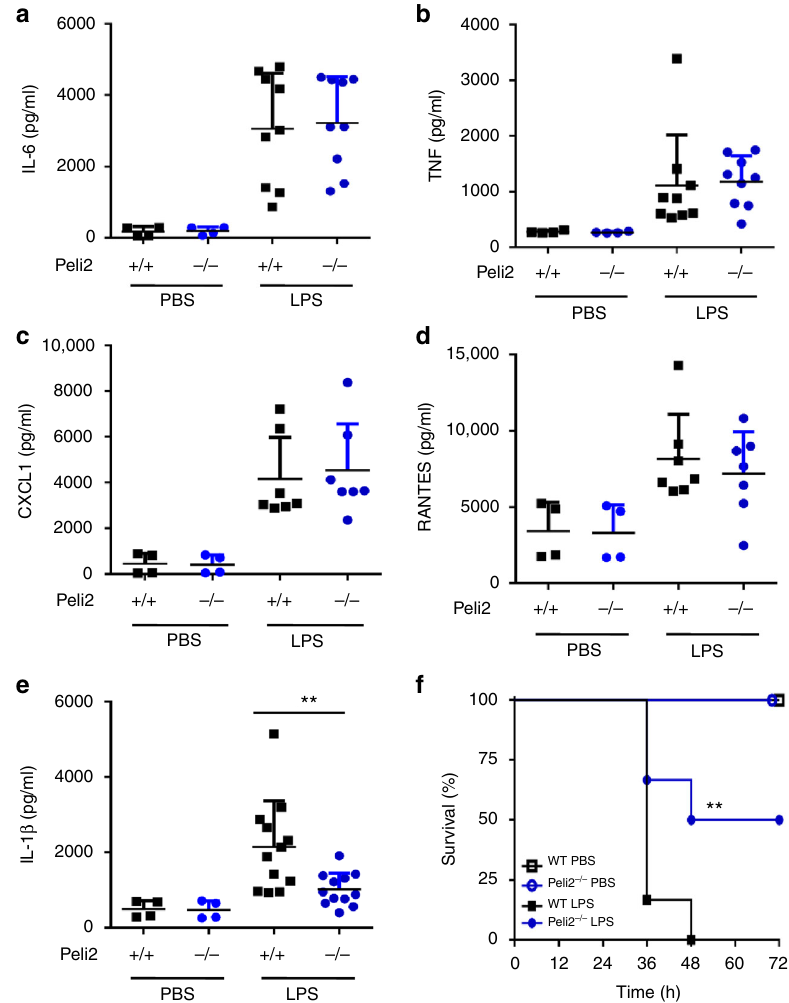
Fig. 3 Pellino2 is required for in vivo expression of IL-1 β and lethality in response to LPS. ELISA of a IL-6, b TNF, c CXCL1, d RANTES, and e IL-1 β , from serum of WT and Peli2 − / − mice at 16 h post-intraperitoneal injection with 20 mg/kg LPS or PBS ( n = 7 – 12). f Survival rates of age- and sex-matched WT ( n = 12) and Peli2 − / − ( n = 12) mice after intraperitoneal injection with 50 mg/kg of LPS or PBS ( n = 4 for each of WT and Peli2 − / − ) as a vehicle control. Mice were monitored every 6 h for 72 h. ** P < 0.01 (paired, two-tailed Student ’ s t -test ( e ) and log-rank Mantel-Cox test ( f )). Data indicate samples from individual mice ( n = 4 for all PBS groups ( a – f ), n = 9 for LPS groups ( a ), n = 8 for LPS/WT, n = 9 for LPS/ Peli2 − / − ( b ), n = 7 for LPS groups ( c, d ), n = 11 for LPS/ WT, n = 12 for LPS/ Peli2 − / − ( e ). Data are pooled biological replicates from two independent experiments. Error bars,